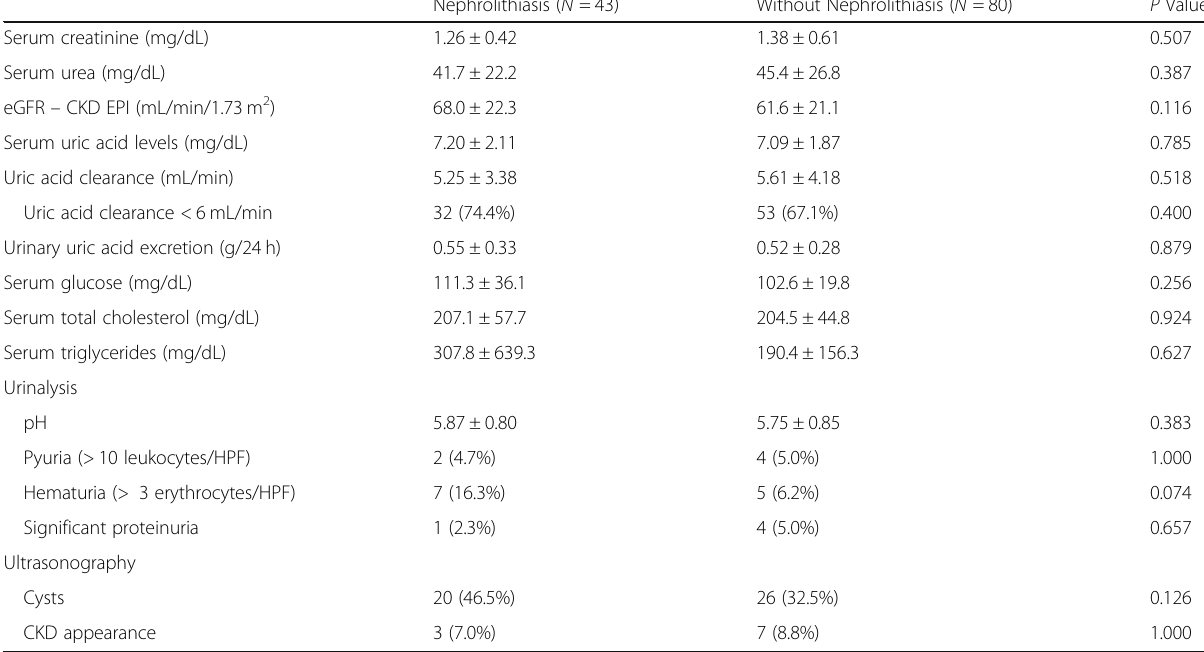
Table 5 Comparison between patients with and without nephrolithiasis (laboratory and ultrasonography